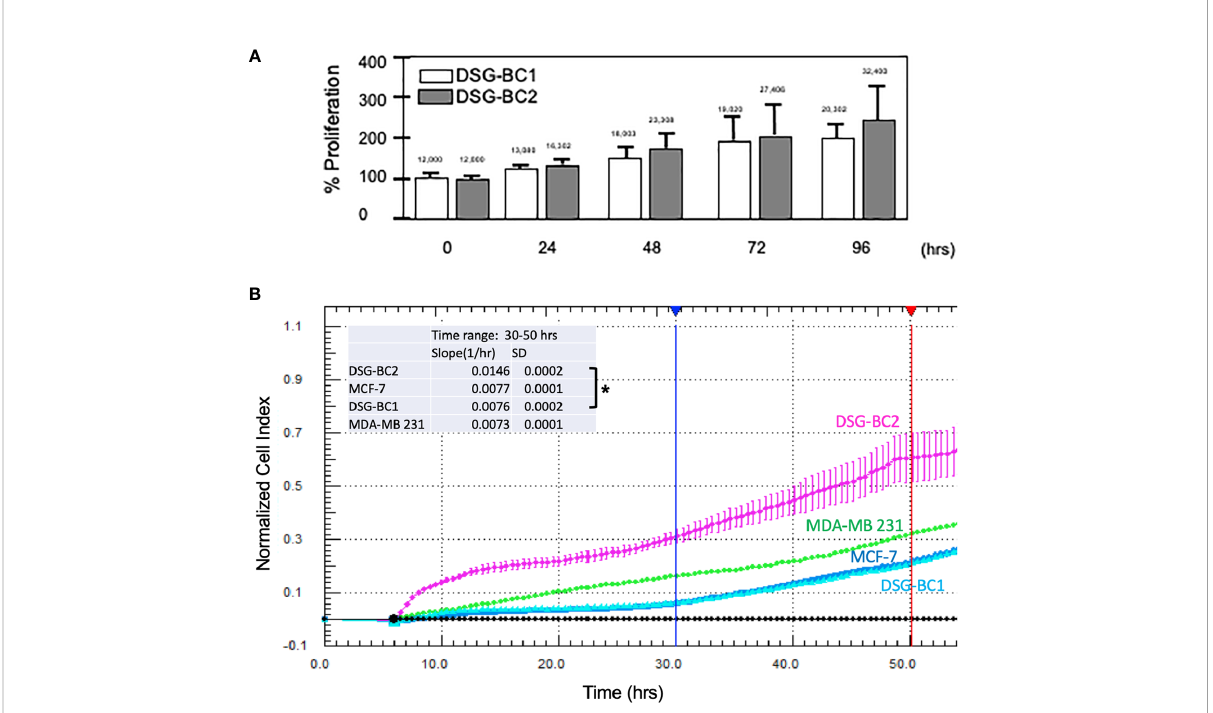
FIGURE 3 Breast cancer cells derived from a patient with obesity display a higher proliferation rate than the one derived from a patient with normal weight. (A) Direct cell counts every 24 h. Numbers above each bar represent the average cell number. (B) Normalized cell index measured every 30 min between 0 and 5 h. The inset represents the slope (change in normalized cell index/h) between 30 (blue vertical lines) and 50 h (red vertical line) of continuous growth. In panel (B) , MCF-7 and MDA-MB-231 cell lines were included as reference in cell growth. Experiment performed in triplicates; values represent average +/ − standard deviation of the mean, n = 3. Vertical bracket indicates comparison between the two newly described cell lines, p value < 0.05